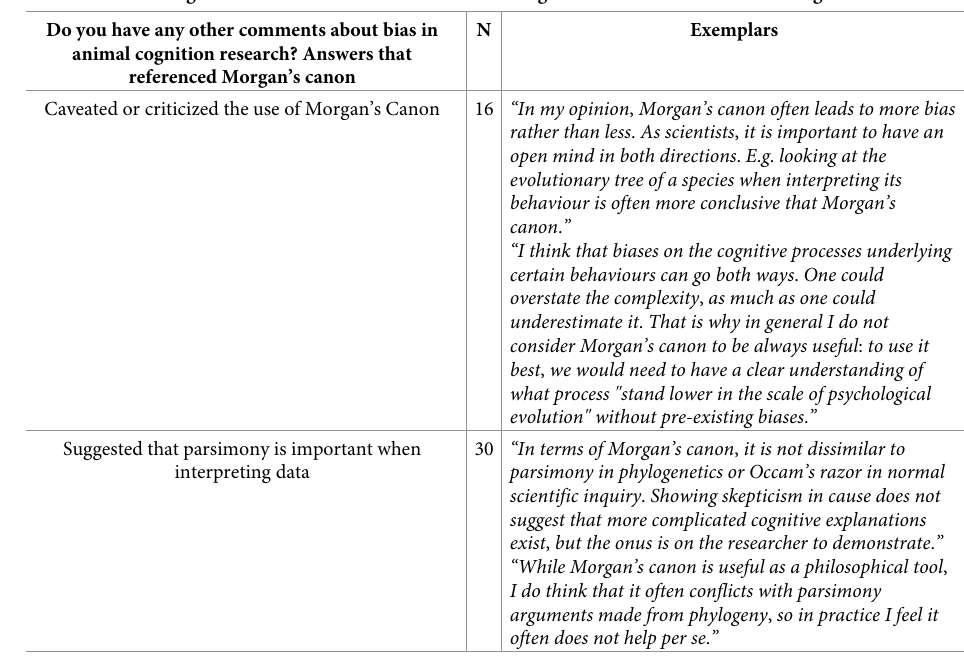
Table 3. Animal cognition researchers’ attitudes towards Morgan’s canon as a tool in animal cognition